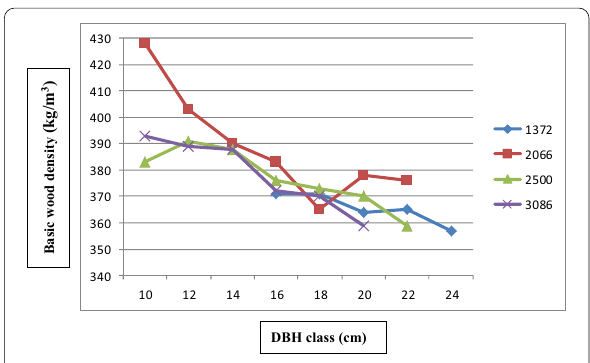
RS radial shrinkage, TS tangential shrinkage, LS longitudinal shrinkage, VS volumetric shrinkage, WD basic wood density ** Significant at the 0.01 level; *significant at the 0.05 level